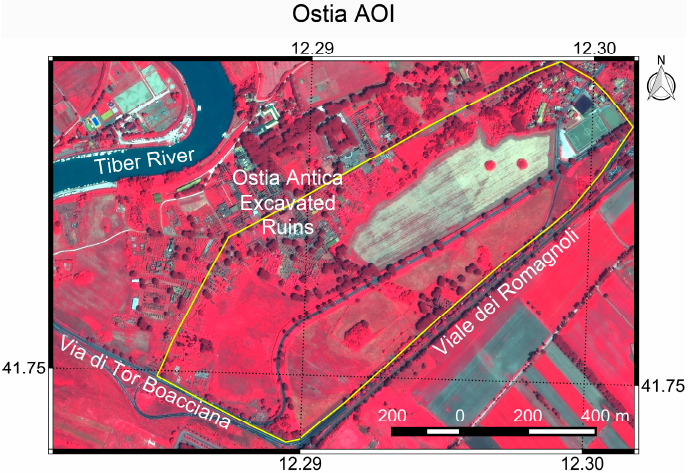
Figure 19. Ostia AOI shown as yellow polygon on Pleiades image acquired on 8 May 2014. The image was pan-sharpened to 0.5 m spatial resolution, and is displayed as NIR, R and G respectively as R, G and B. Pleiades data provided by the European Space Agency.